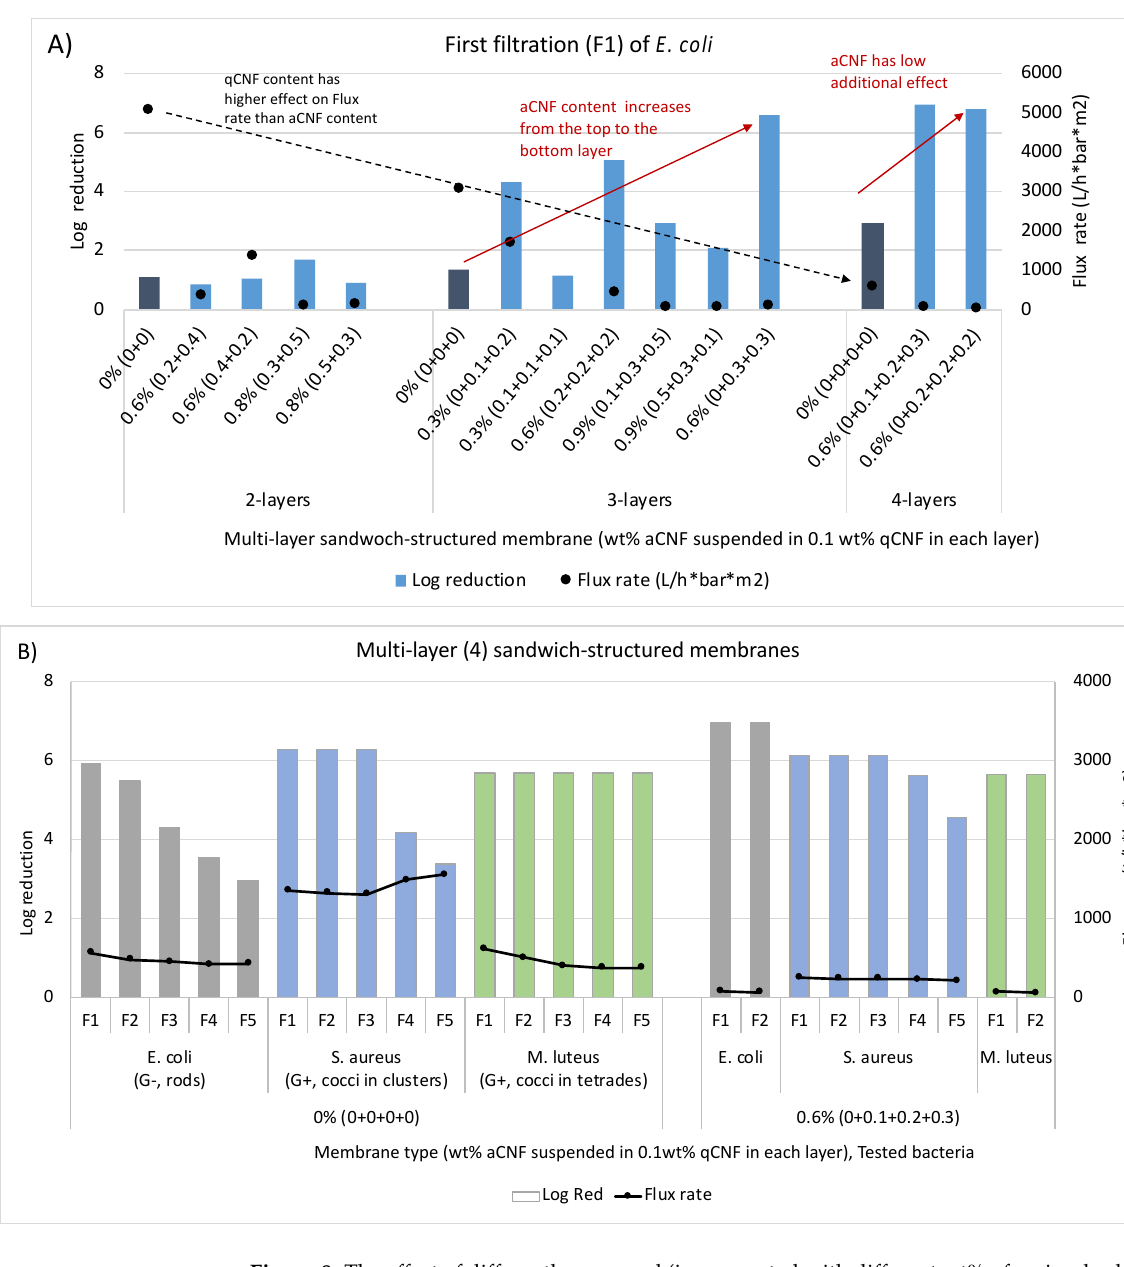
Figure 8. The effect of differently prepared (impregnated with different wt% of amino-hydrophobised CNF/aCNF, pre-suspended in 0.1 wt% quaternised cellulose nanofibrils/qCNF) sandwich (multi-layered) membrane on flux rate of (300 mL) bacterial suspension with log reduction values for ( A ) rod-shaped ( G− ) Escherichia coli (EXB-V127) vs. ( B ) round-shaped (G+) Staphylococcus aureus (EXB-V54) and Micrococcus luteus (EXB-V52), performed with vacuum filtration at a pressure of 0.6 bar and room temperature.